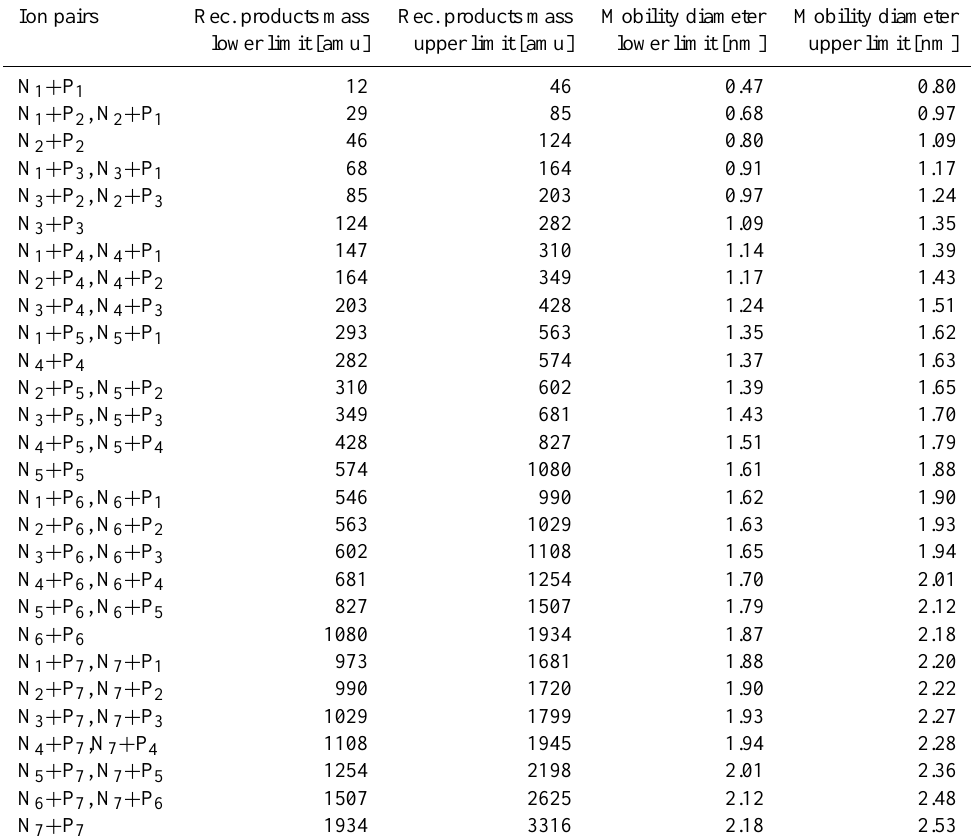
Table 3. The mass and size ranges of the recombination products formed in the collisions of different ion pairs. N and P refer to the negative and positive ions and the numbers from 1 to 7 to the different NAIS channels shown in Table 2.